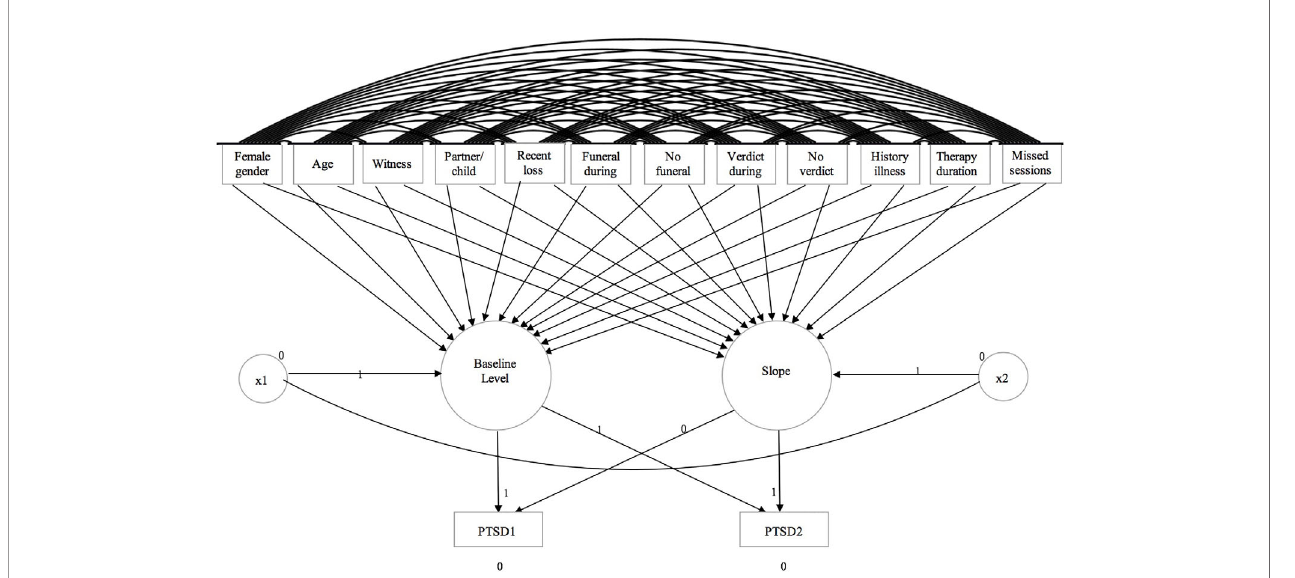
FIGURE 1 | Example of the latent growth model with PTS symptoms as